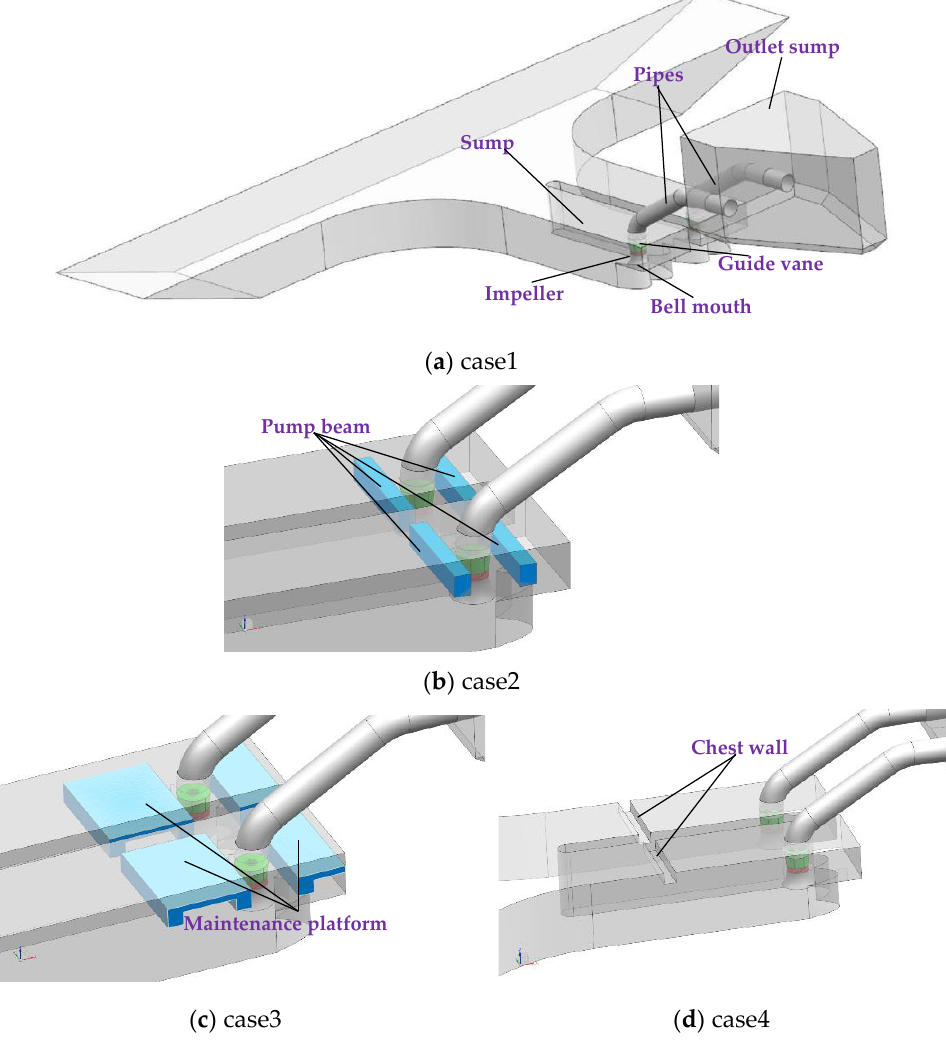
Figure 1. Design case of entering sump structure.